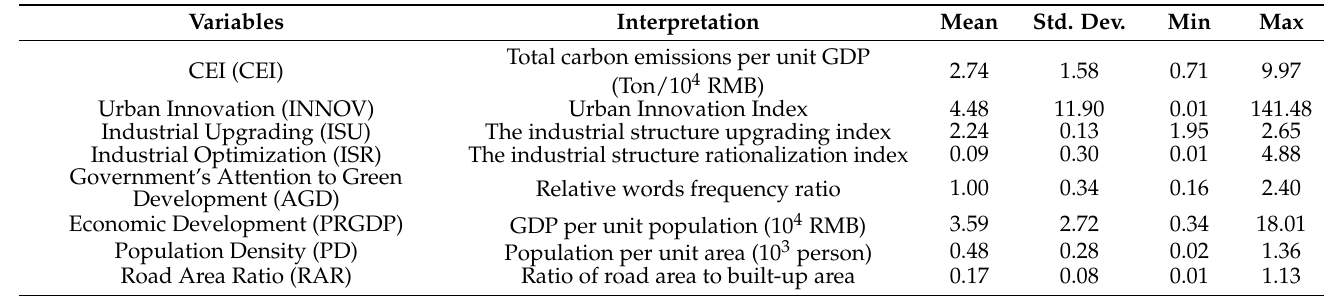
Table 1. Descriptive statistics of main